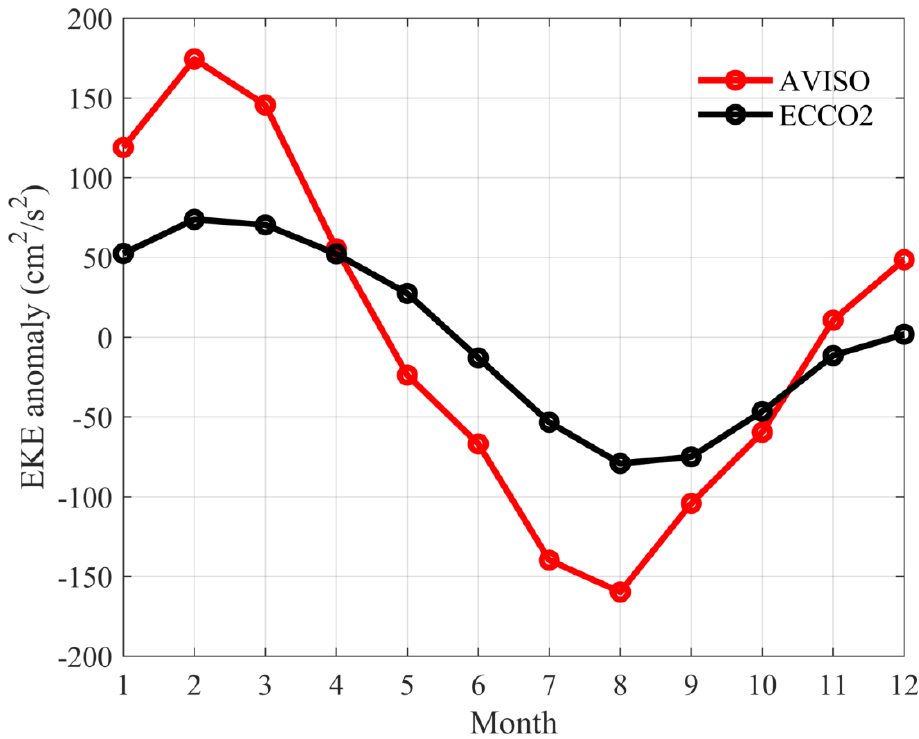
Figure 3. Surface EKE time series averaged in 150 − 160° E, 25 − 38° S as a function of months. EKE is calculated by using surface velocities of AVISO (red line) and ECCO2 (black line).